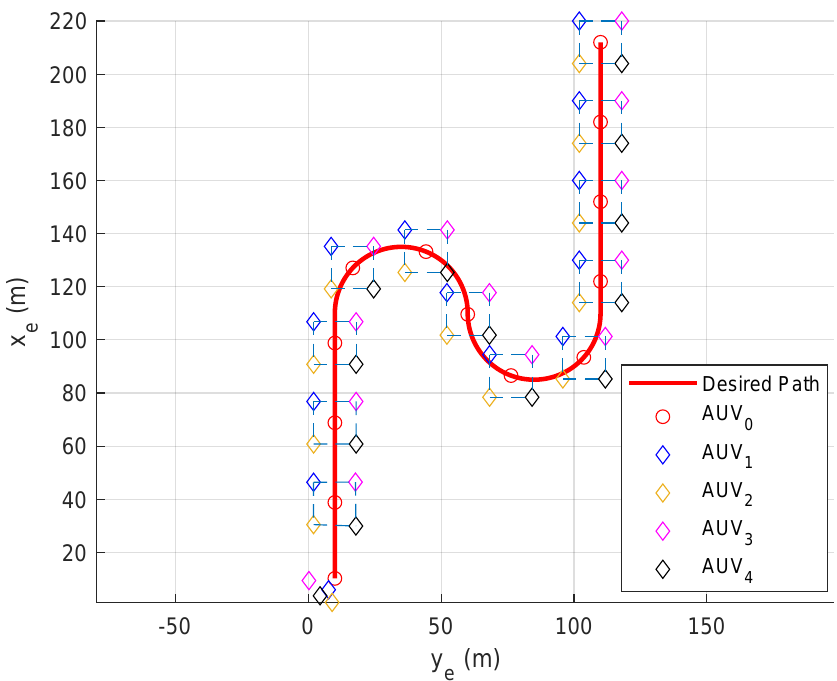
Figure 7. Trajectory of multi-AUV under ideal communication topology without delay.